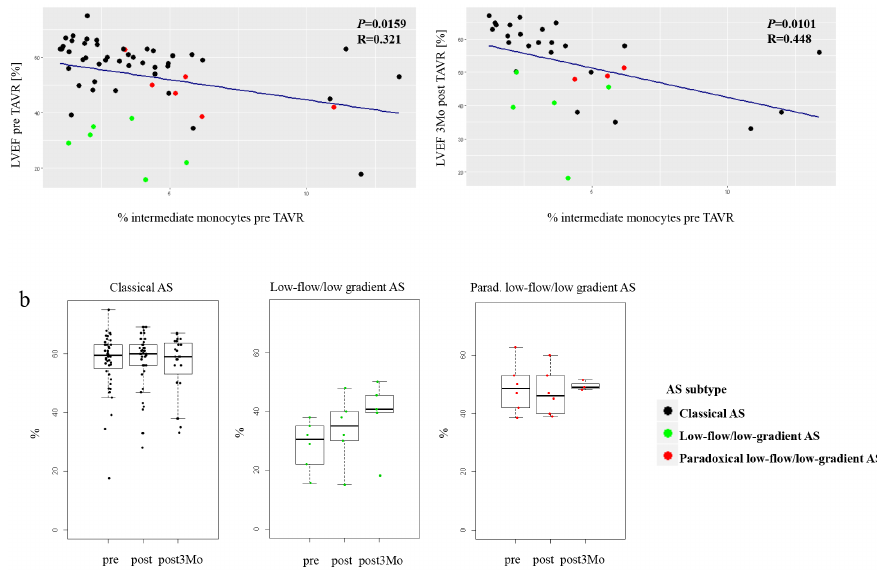
Fig 2. Intermediate monocytes and LVEF. (a) Correlationbetweenintermediate monocytesmeasuredby flow cytometry before TAVR-procedure and LVEF before and three months after TAVR-procedure. (b) Development of LVEF over time split up for different AS